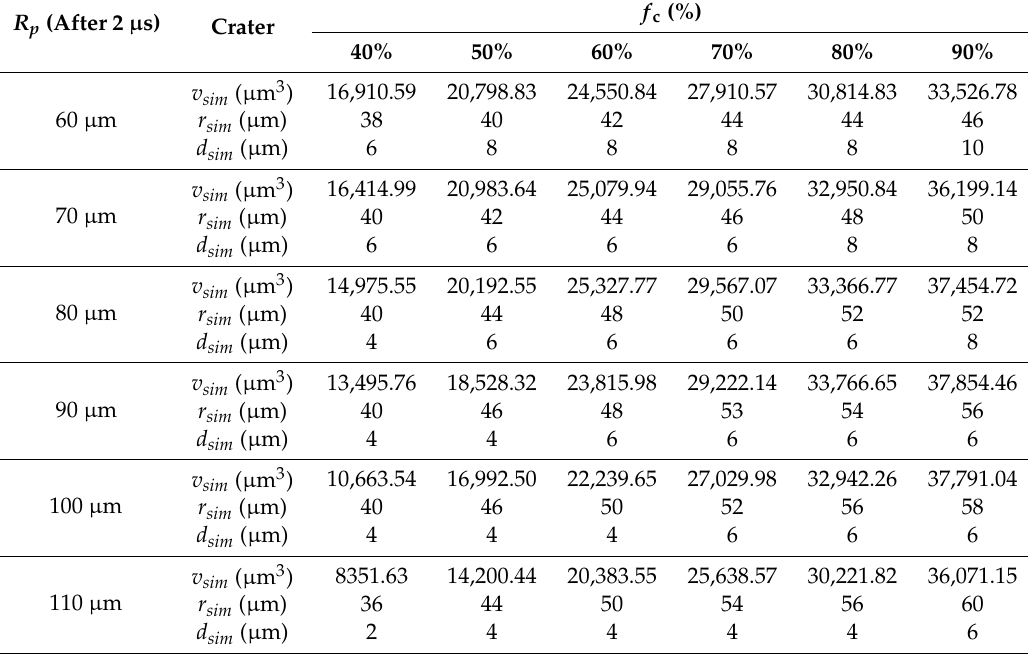
Table 6. Crater dimensions from numerical simulation of di ff erent combinations of heat partition to the workpiece ( f c ) and radius of the plasma channel after 2 µ s.